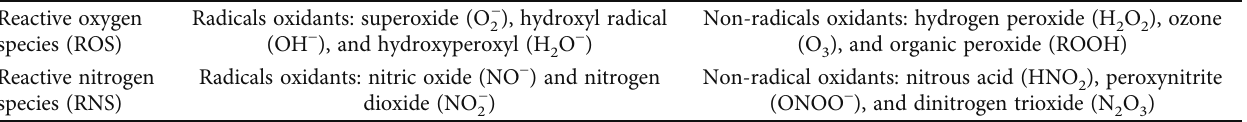
Table 1: Example of ROS and RNS radicals and non-radicals